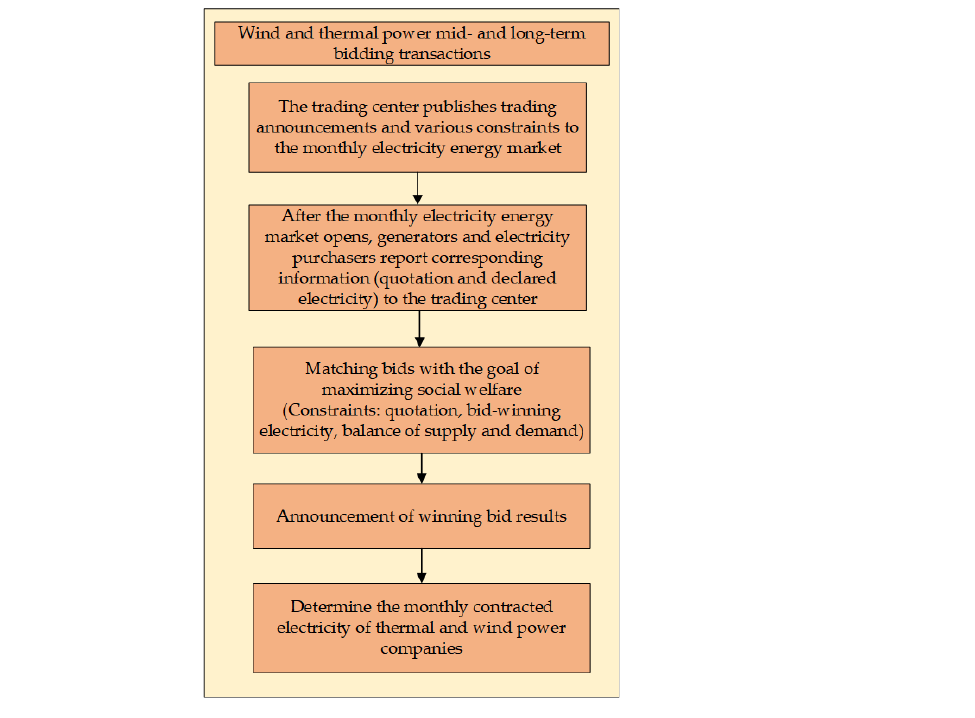
Figure 2. Mid- and long-term transaction flow chart.